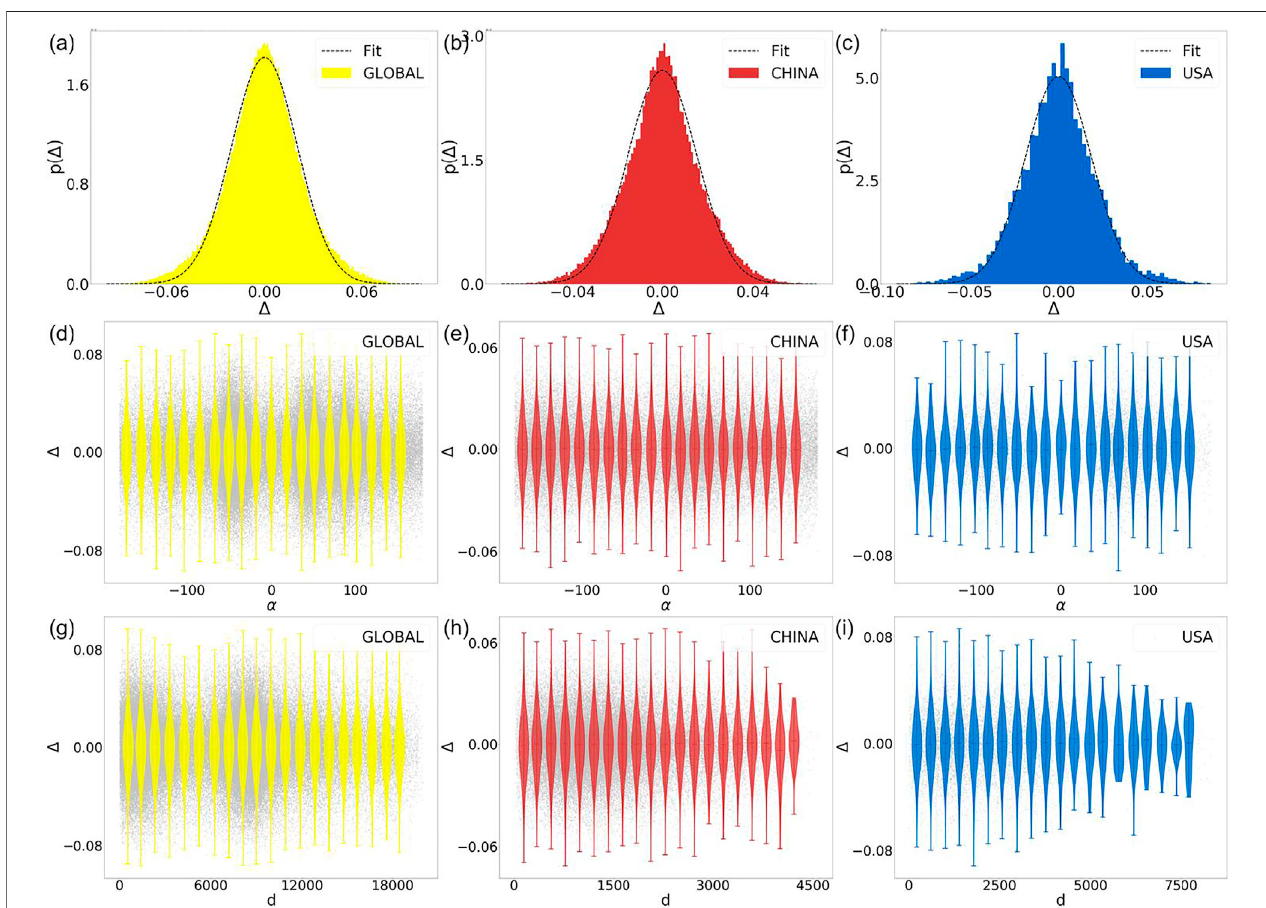
FIGURE 4 | The causality analysis of the PM 2 . 5 time series. (A – C) show the Δ distributions for the global, Chinese, and American stations, respectively. The bar graph shows the distribution characteristics of the real data, and the black dotted line shows the normal fi t of the curve. (D – F) show azimuth α in comparison to Δ regardingthe global,China, and American data, respectively. Finally, (G – I) compare distance d to Δ regardingtheglobal,Chinese,and Americandata,respectively. The violinplotspresenttheoveralldistributioncharacteristicsofeachdatagroup.Theupperandlowerendsarethetopandthebottomofeachviolin ’ sdistribution,and the middle lines are the means of each violin ’ s distribution. The gray dots are a scatterplot of the original data.